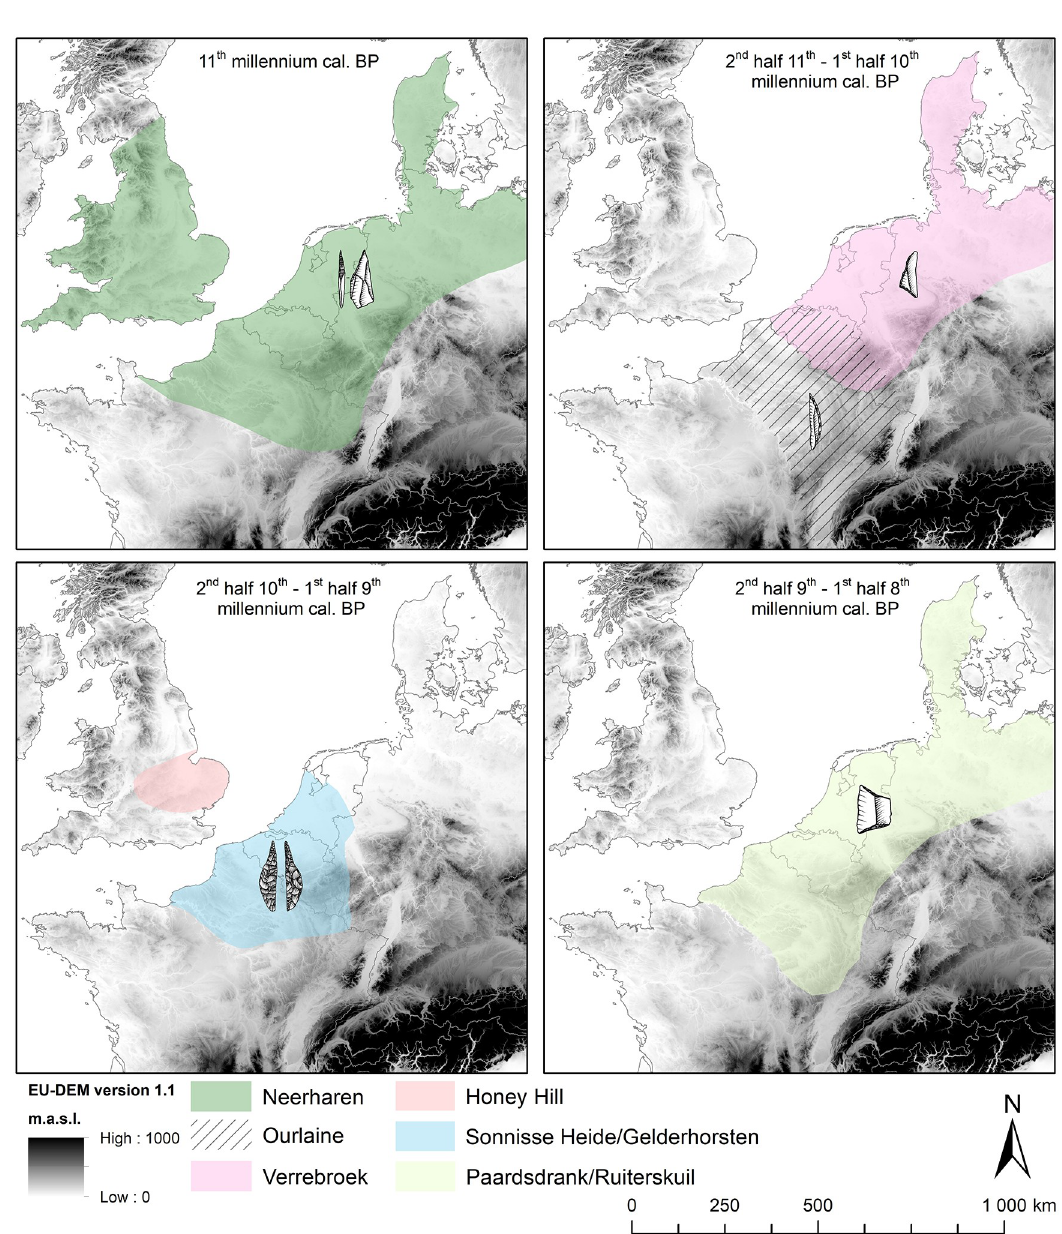
Fig 4. General distribution maps of the ATs within the RMS region. Source map (European Union, Copernicus Land Monitoring Service 2019, European Environment Agency (EEA)).